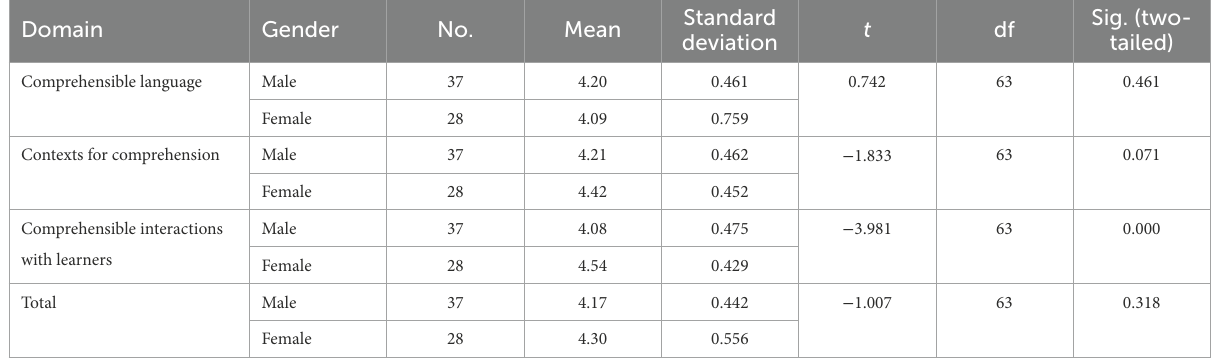
TABLE 7 T -test analysis. Domain